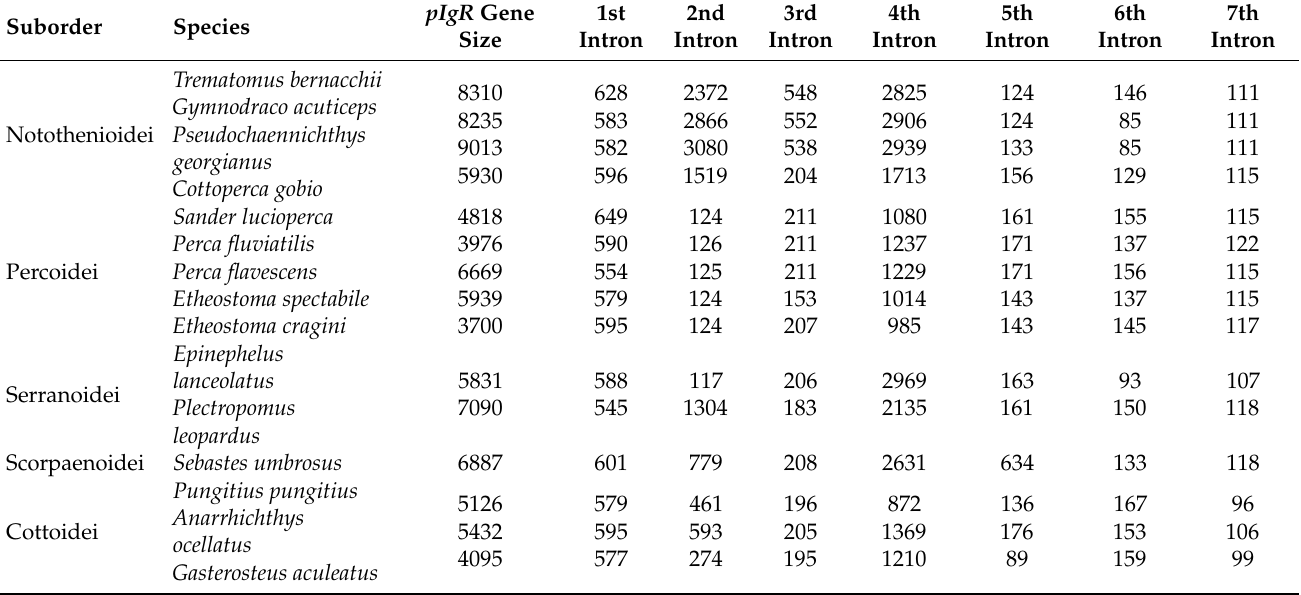
Table 1. The polymeric Ig receptor ( pIgR ) gene size and intron length (nt) in the perciform suborders Notothenioidei, Percoidei, Serranoidei, Scorpaenoidei, and